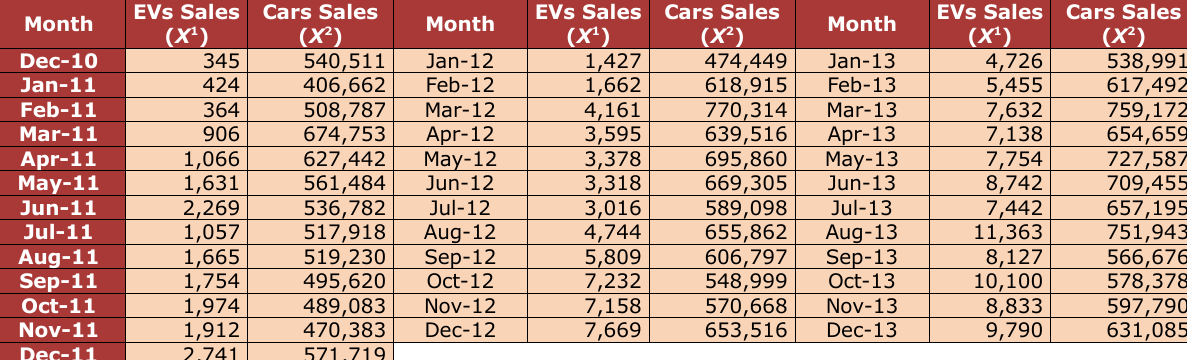
Table 1. EVs monthly sales and Cars sales from Dec. 2010 to Dec. 2013 in USA. Data was from Argonne National Laboratory and U.S. Department of Energy